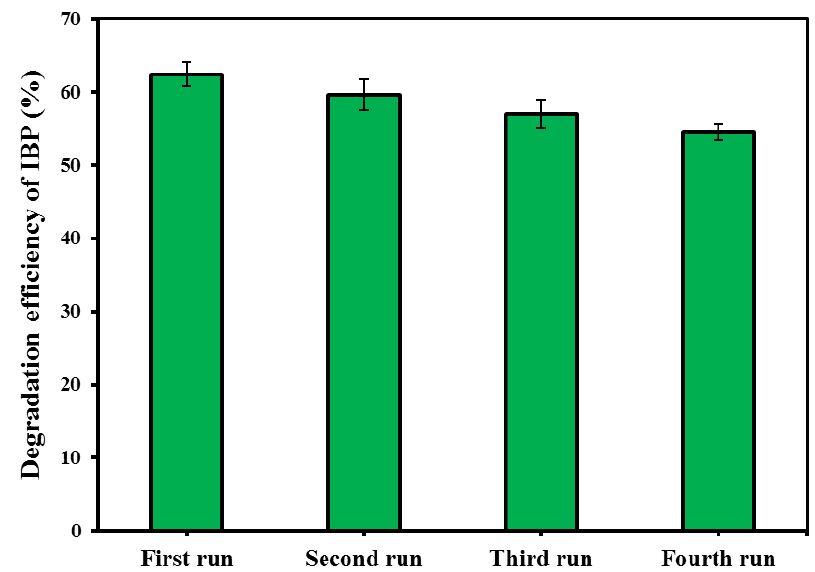
Figure 6. Reusability test results within four consecutive experimental runs.